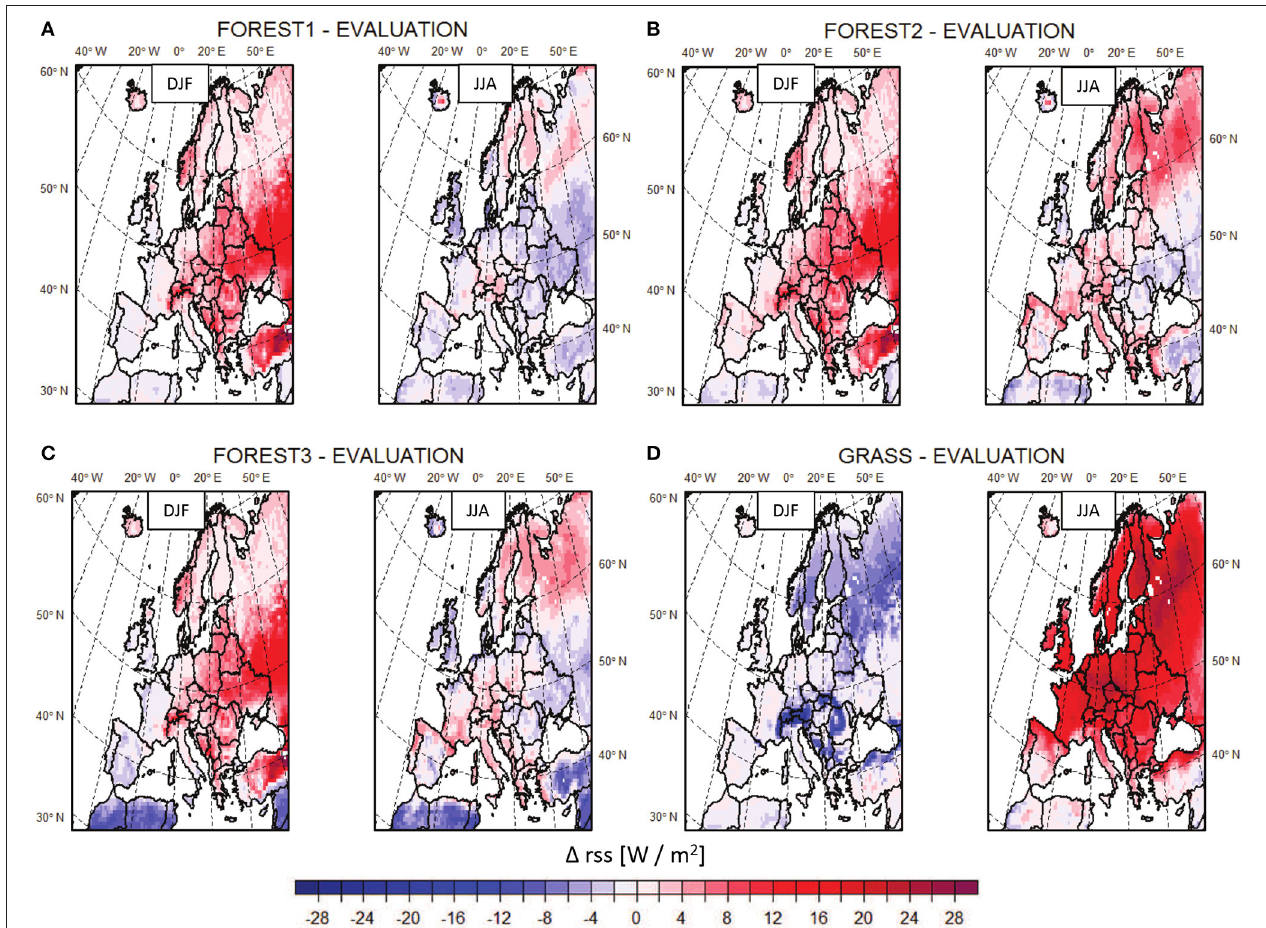
FIGURE 8 | Spatial distribution of mean net shortwave flux changes over the EURO-CORDEX domain for the conversion to forest with three different albedo parameterizations [FOREST1 (A) , FOREST2 (B) , FOREST3 (C) ], and to grassland [GRASS (D) ] for winter (DJF, left) and summer (JJA, right) for 1986–2015. The difference between experiments and the EVALUATION simulation with no land cover change is displayed over land points